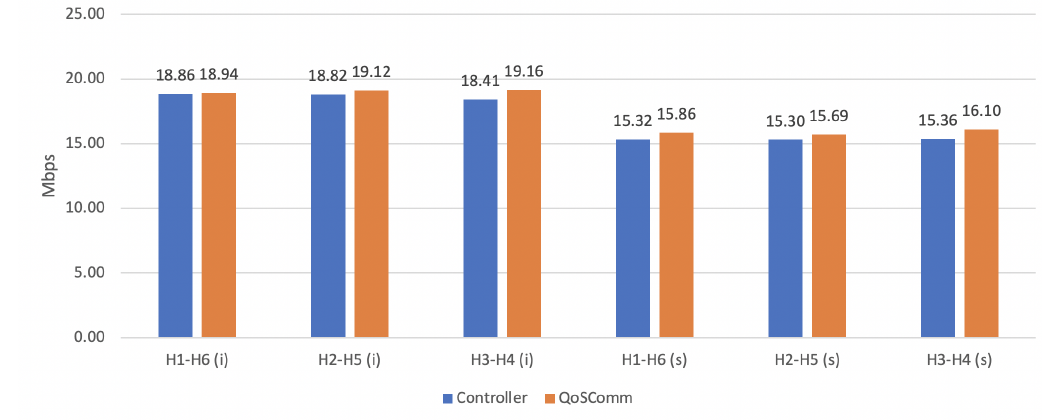
Figure 7. D-ITG data transfer comparison (average mbps). Tests execution: (i) individually; (s) simultaneously. Time interval: 30 s. STDEV: H1-H6i (0.36, 0.60), H2-H5i (0.13, 0.21), H3-H4i (0.50, 0.05); H1-H6s (0.78, 0.05), H2-H5s (0.42, 0.16), H3-H4s (0.13,